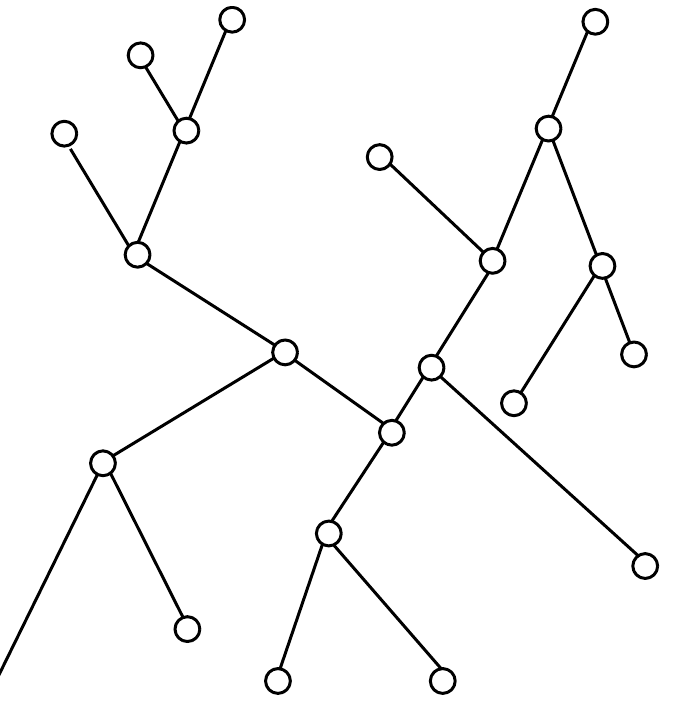
Fig 3. A general tree. For illustrationpurpose, heightof a node representsits function value. A generaltree may have both downforkand upfork branching nodes.